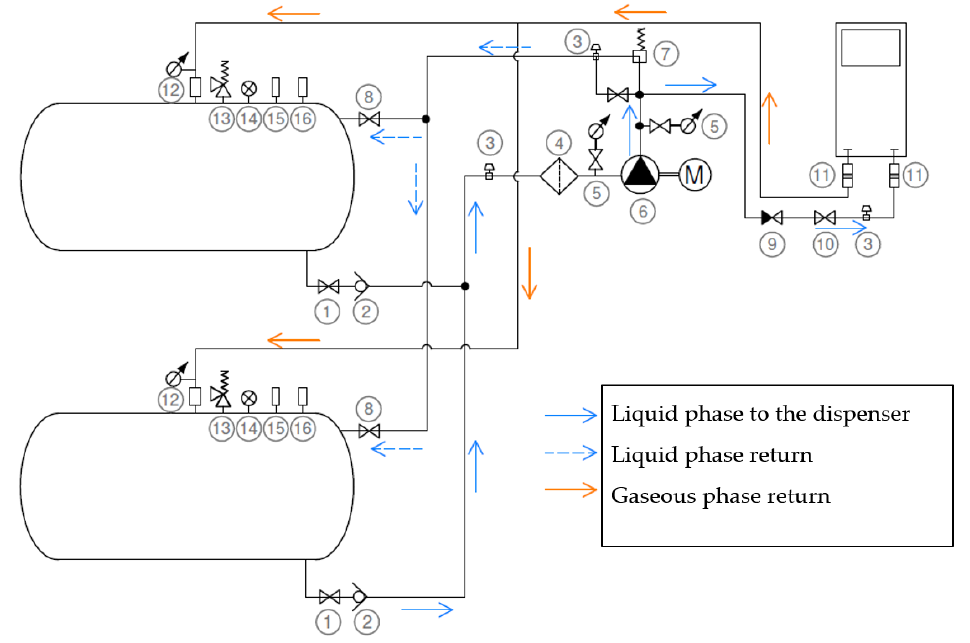
Figure 1. Flow diagram of liquid gas filling system, where (1) liquid phase intake ball valve, (2) overflow valve, (3) hydrostatic valve, (4) liquefied gas filter, (5) dial pressure gauge, (6) liquefied gas pump, (7) by-pass overflow valve, (8) liquid phase intake valve, (9) non-return valve, (10) ball valve, (11) emergency release coupling, (12) gaseous phase intake valve with pressure gauge, (13) safety valve, (14) tank filling indicator, (15) valve of tank filling by tank truck, (16) storage tank emergency drain valve.